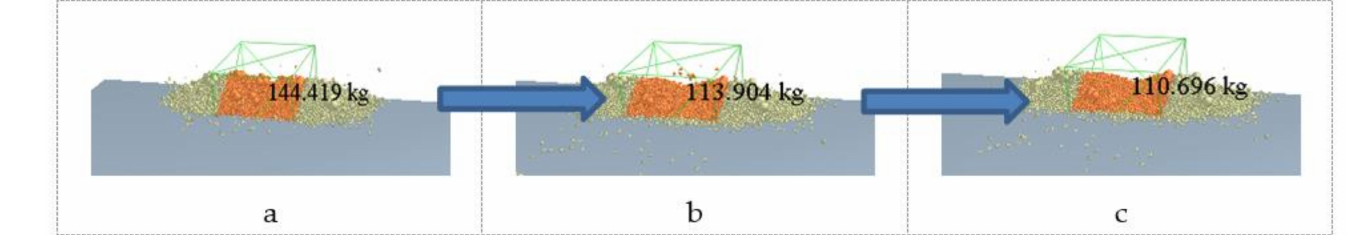
Figure 16. Simulation process of airduct mouth direction angle, 45 ◦ . ( a ) soil ridge mass at 0.5 s/(kg), ( b ) soil ridge mass at 1.5 s/(kg), ( c ) soil ridge mass at 2 s/(kg).